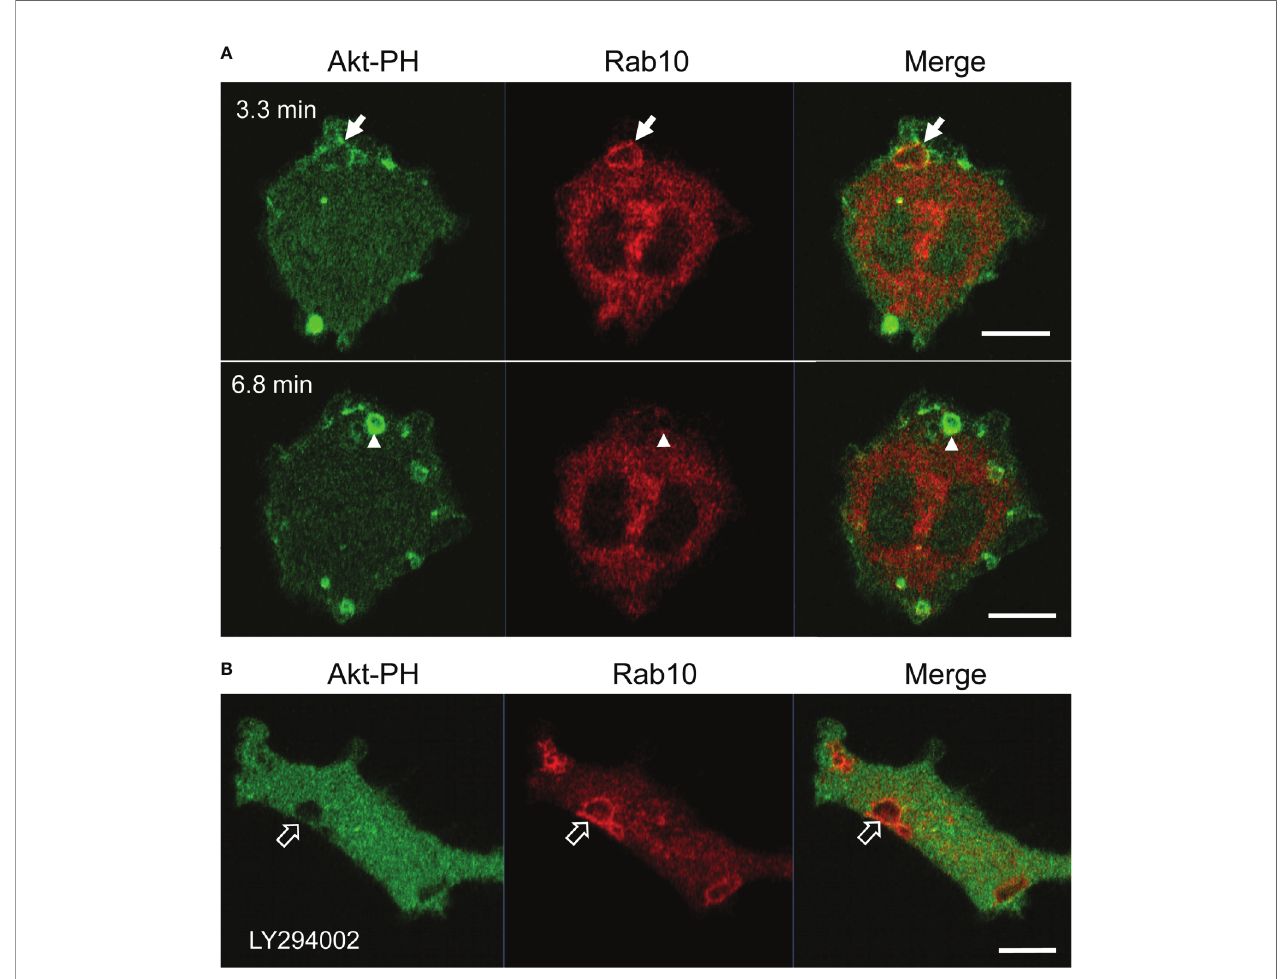
FIGURE 8 | Premacropinosome formation and the recruitment of Rab10 are not PI3K-dependent. The PI(3,4,5)P 3 /PI(3,4)P 2 production by class I PI3K was monitored through the expression of mCitrine-Akt-PH domain (Akt-PH, green) in RAW264 cells during PA-Rac1 ON-OFF cycling (A) Although only small amounts of Akt-PH were observed on Rab10-positive premacropinosomes (arrows), Rab10-negative premacropinosomes were strongly positive for Akt-PH (arrowheads) at the timing of macropinosome closure. Elapsed time is shown in the frame. (B) In the presence of 10 m M LY294002, a PI3K inhibitor, the formation of Rab10-positive premacropinosomes was frequently seen (open arrows), whereas Akt-PH recruitment to the membrane was completely abolished. All scale bars = 10 m m. The corresponding movies are available in the ( Supplementary Material Movie 15